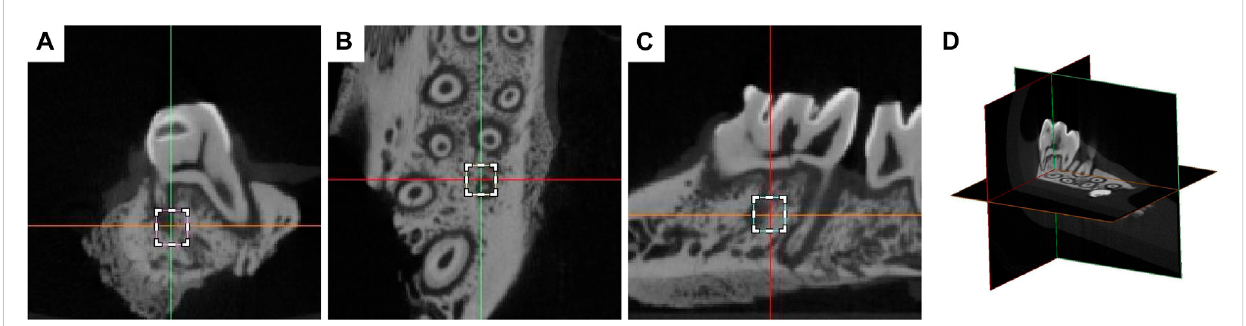
FIGURE 2 De fi nition of the region of interest (ROI) on the coronal view (A) , axial view (B) , sagittal view (C) of micro-CT, and the three-dimensional overall view (D) .TheregionofROIwasde fi nedasa700 μ m×700 μ m×700 μ mcubeinthemesialalveolarboneintervalinthemiddle1/3ofthedistalandlabialroot, 200 μ m from the root